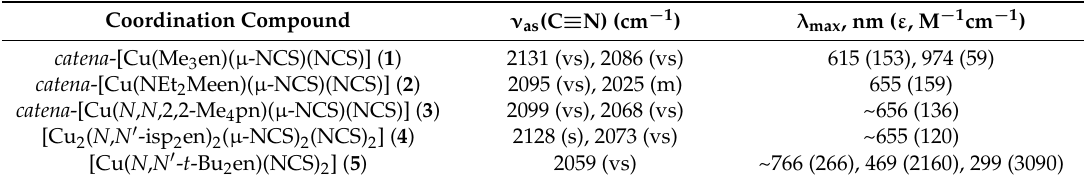
Table 1. The IR asymmetric stretching frequency of the coordinated isothiocyanato groups and UV-Vis spectra of the coordination compounds 1 – 5 in CH 3 CN